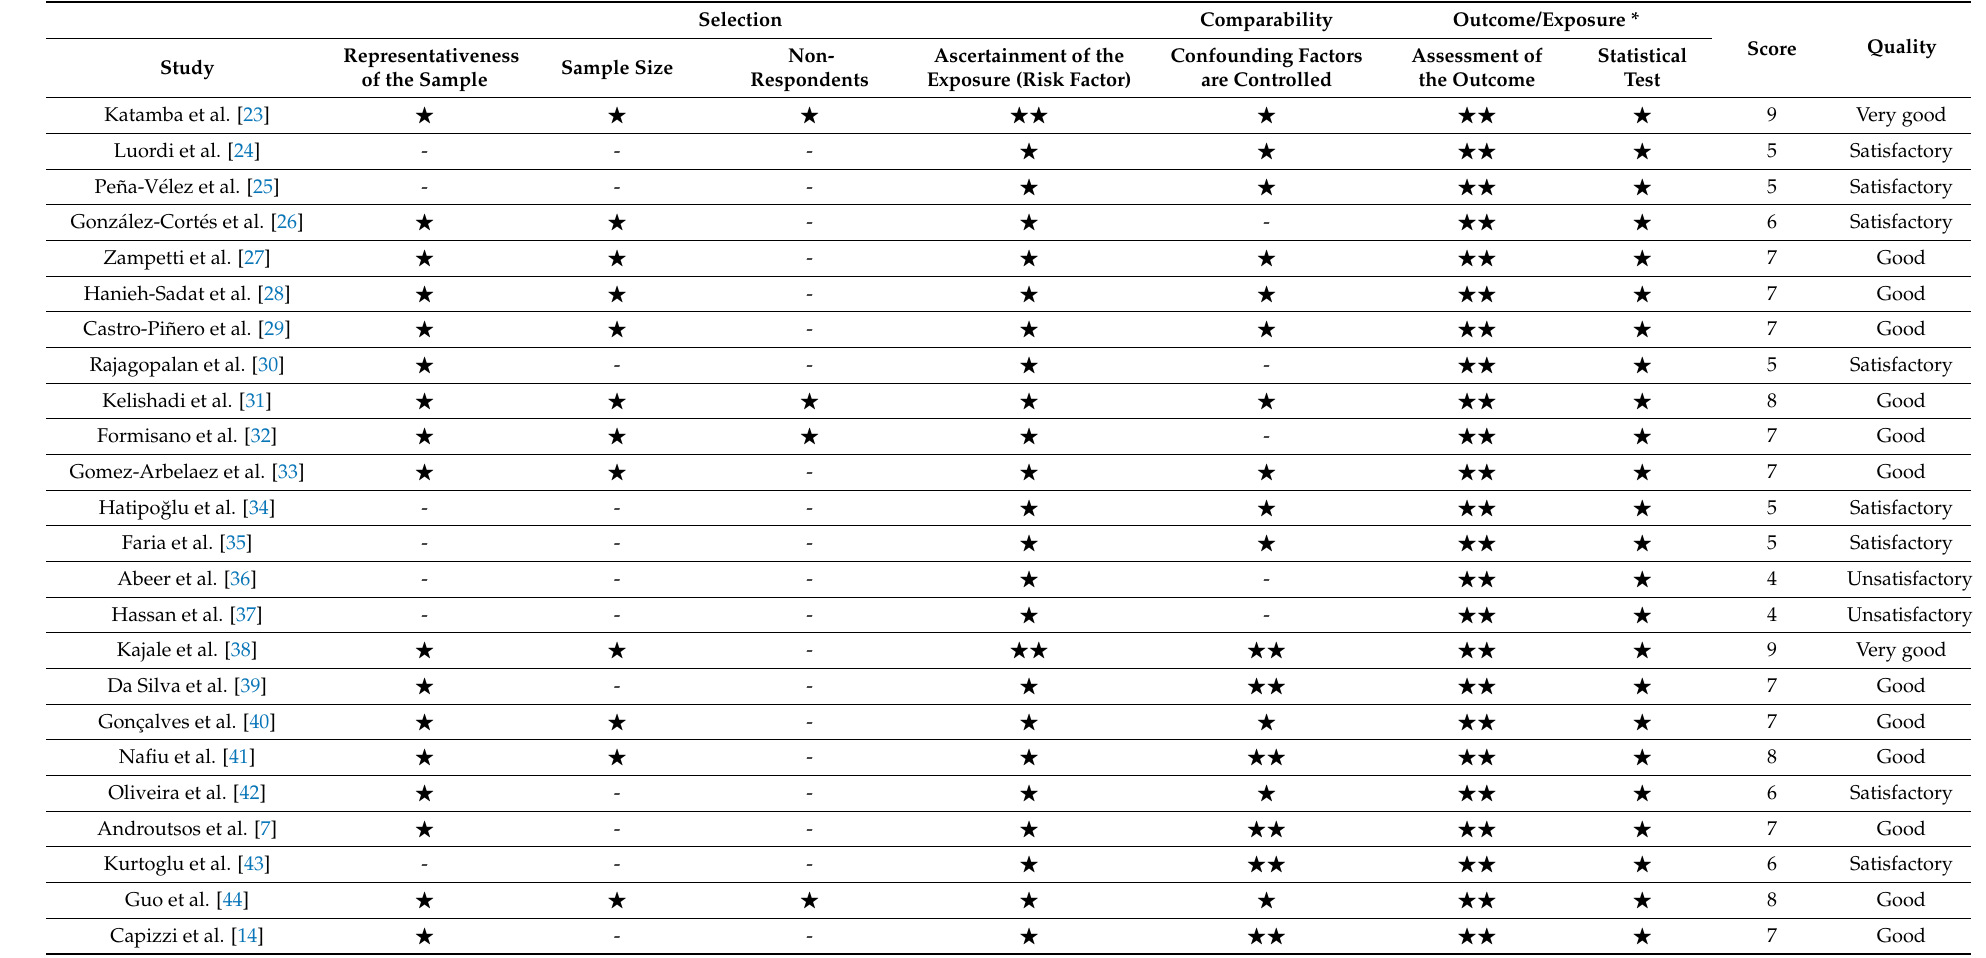
Table 2. Quality assessment of the